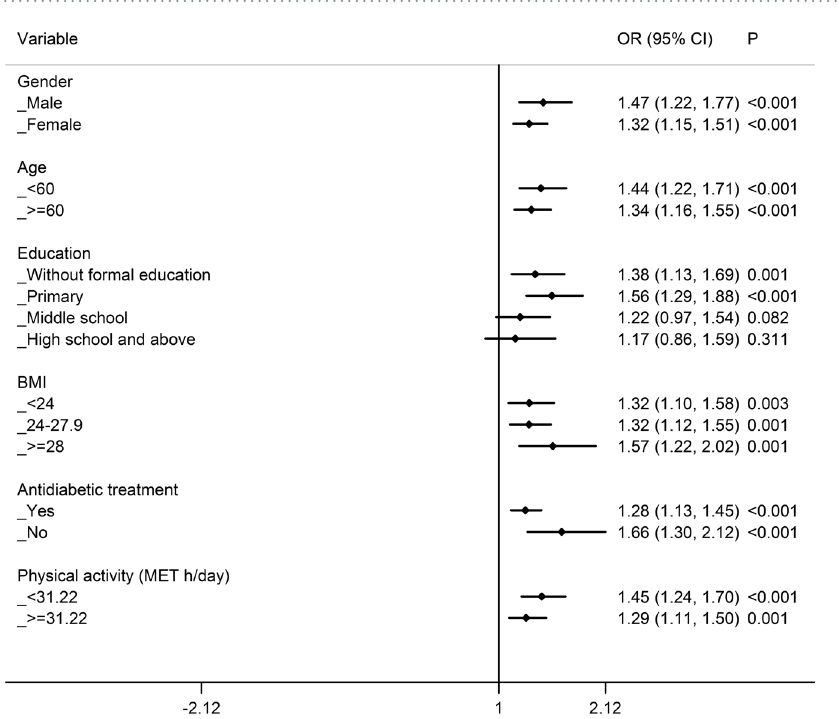
Figure 1. Stratified analysis of the comparison of poor glycaemic control between T2D patients with and without a FH of diabetes by age, gender, education, BMI, antidiabetic treatment and physical activity. Logistic regression was used to estimate the OR (95%CI) and each stratified analysis was adjusted for age, gender, education, BMI, antidiabetic treatment, physical activity, smoking, drinking, spouse with diabetes and duration of diabetes except the corresponding stratification factor. OR: odds ratio; CI: confidence